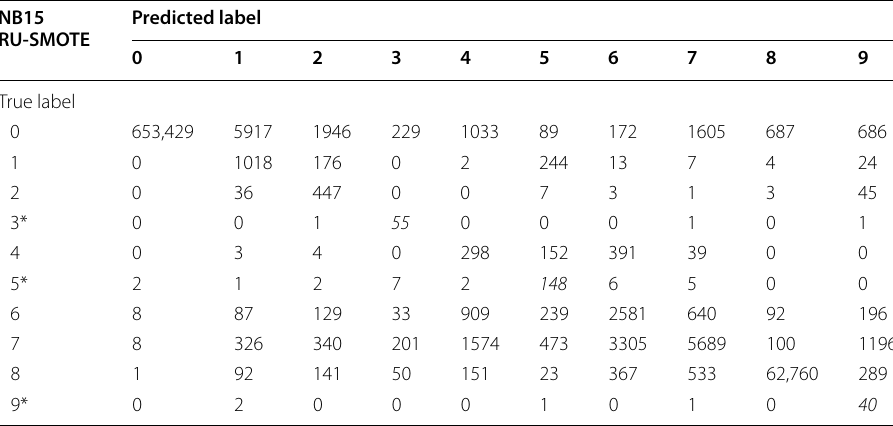
Table 26 Confusion Matrix: NB15